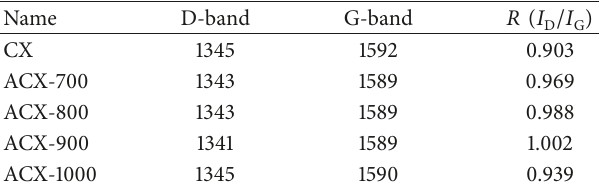
/𝐼 ) of CX and ACX- T D G